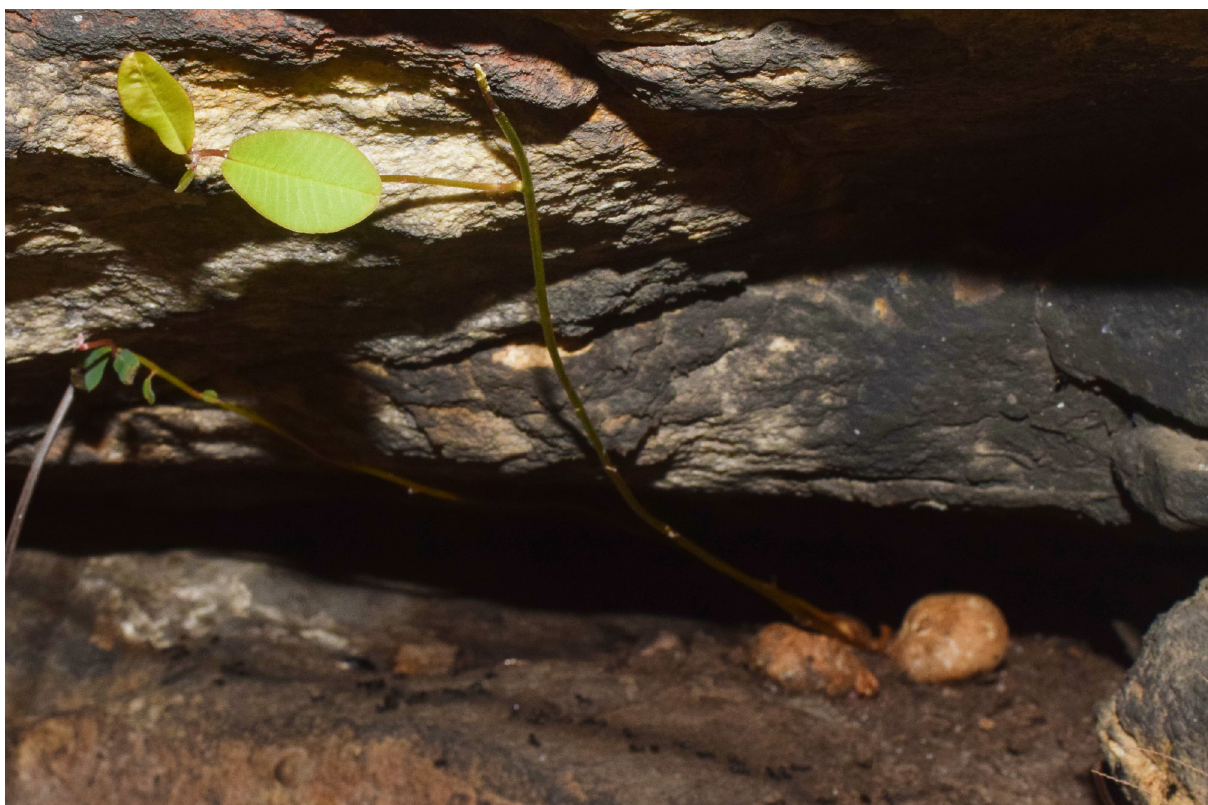
A Heeria argentea seedling emerges from a dark, rocky crevice at Limietberg Nature